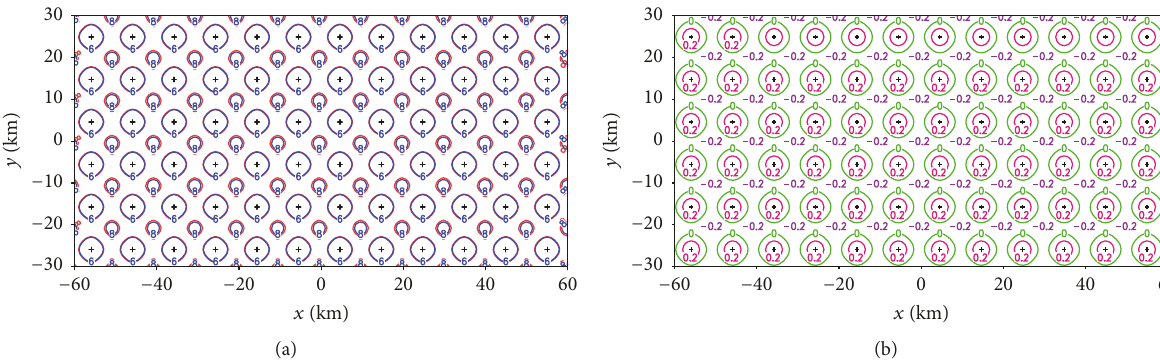
Figure 10: (a) Benchmark analysis error variance 𝜎 2 𝑎 ( x ) plotted by red contours of every 2 m 2 s −2 and estimated analysis error variance 𝜎 2 𝑎 ∗ ( x ) in (16) plotted by blue contours. (b) Deviation of 𝜎 2 𝑎 ∗ ( x ) from 𝜎 2 𝑎 ( x ) plotted by colored contours of every 0.2 m 2 s −2 . The black + signs show the locations of 𝑀 (= M M = 12 × 6) uniformly distributed coarse-resolution observations with periodic extension along 𝑥 and 𝑦 . The coarse- x y resolution observation resolution is Δ𝑥 co = 𝐷 𝑥 / 𝑀 𝑥 = 𝐷 𝑦 /𝑀 𝑦 = 10km, and the observation error variance is 𝜎 2 𝑜 = 2.5 2 m 2 s −2 . The background error covariance 𝜎 2 𝑏 𝐶 𝑏 ( x ) has the double-Gaussian form with 𝐶 𝑏 ( x ) = 0.6 exp (−| x | 2 /2𝐿 2 ) + 0.4 exp (−2| x | 2 /𝐿 2 ) , 𝜎 2 𝑏 = 5 2 m 2 s −2 , and 𝐿 = 10 km. The analysis domain length (or width) is 𝐷 𝑥 = 𝑁 𝑥 Δ𝑥 = 120 km (or 𝐷 𝑦 = 𝑁 𝑦 Δ𝑦 = 60 km), and the number of coarse-resolution observations is M = M M = 12 × x y